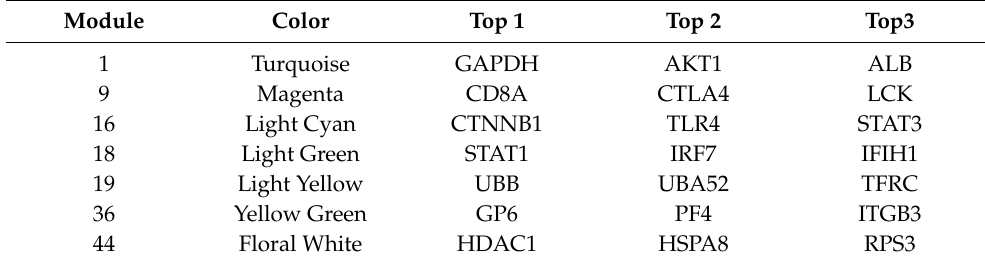
Table 2. Top three hub genes of conserved modules ranked as ranked by cytoHubba after PPI network construction through stringDB.